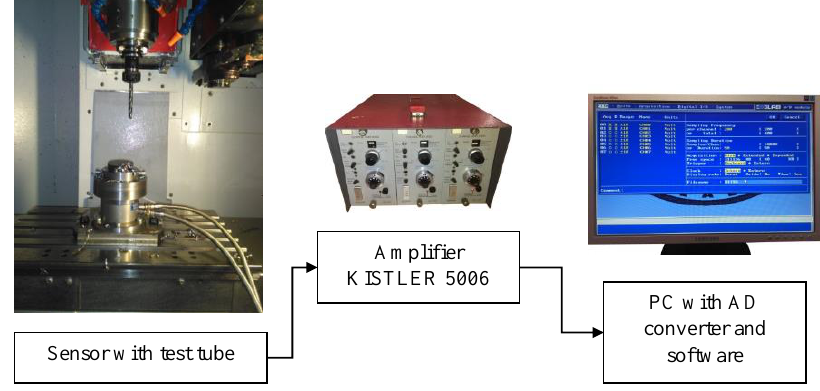
Figure 1. Torque measuring equipment.